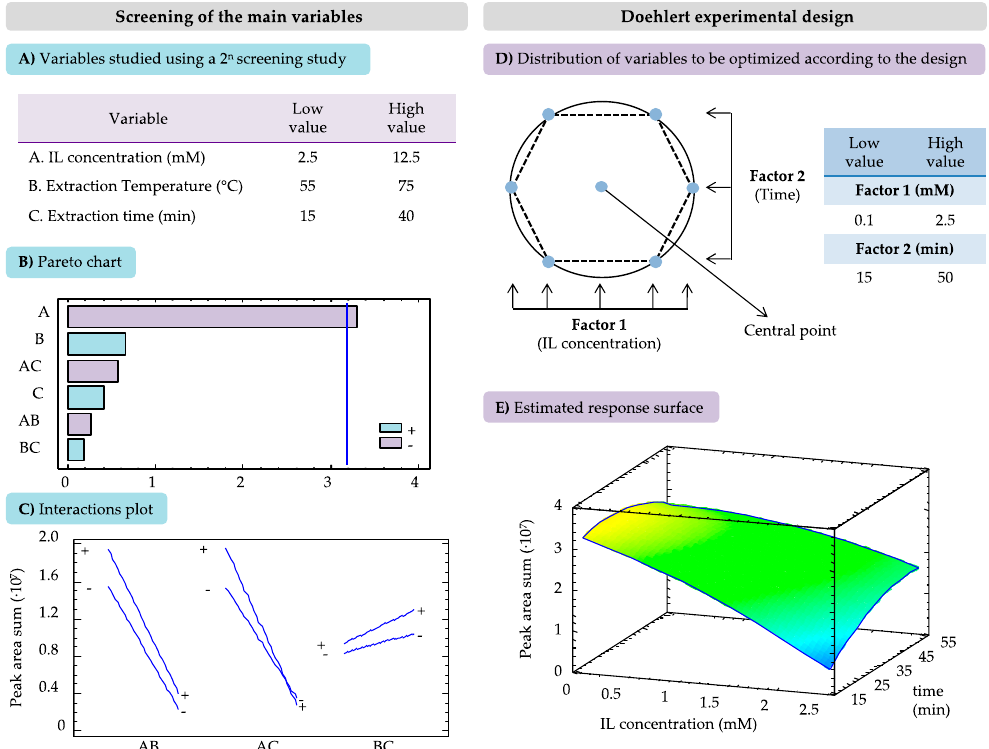
Figure 2. Results obtained in the screening of the main variables and in the Doehlert experimental design, during the optimization of the MA-SLE method. ( A ) Variables considered in the screening process. ( B ) E ff ects of the main factors in the resulting peak area sum for all the compounds. ( C ) Interaction among factors for all the compounds. ( D ) Spatial distribution of the experimental points in the Doehlert design. ( E ) Estimated response surface for peak areas sum for all the compounds, considering IL concentration and time of extraction factors.